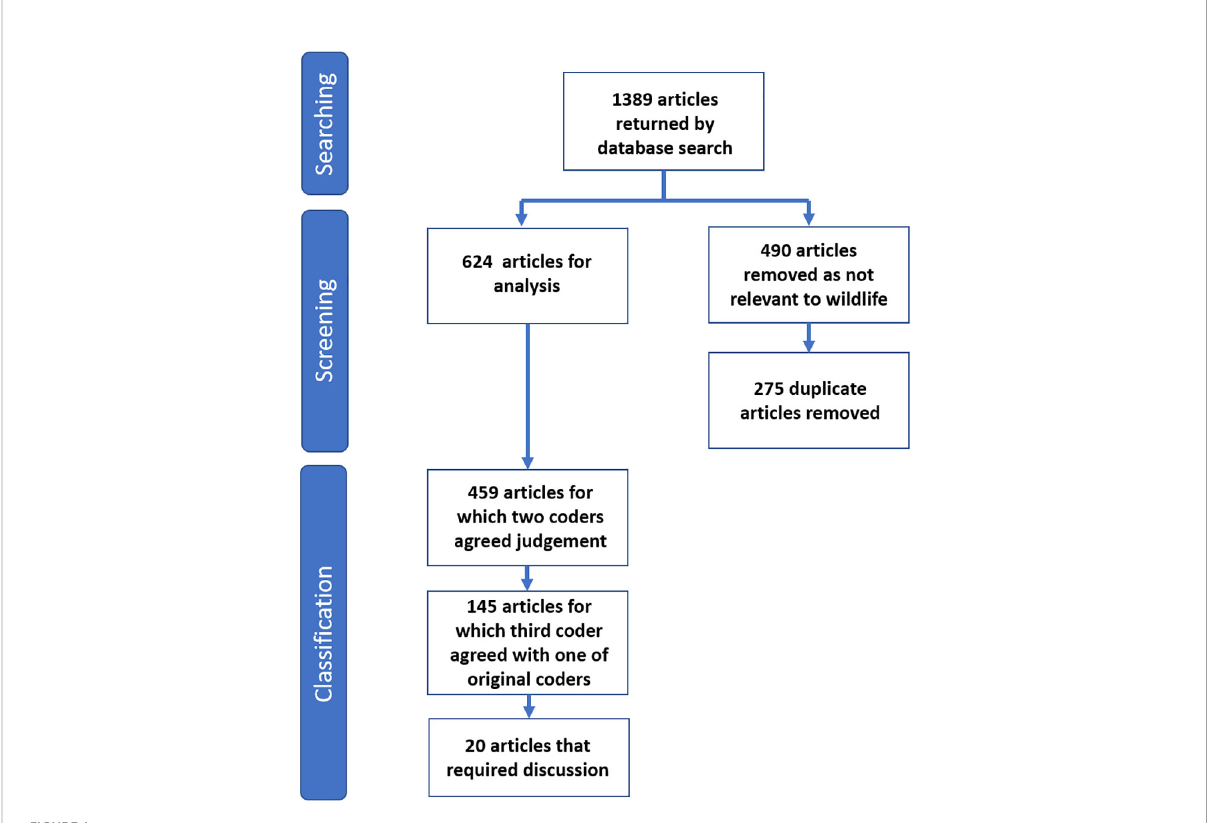
FIGURE 1 The process for selecting and classifying articles according to